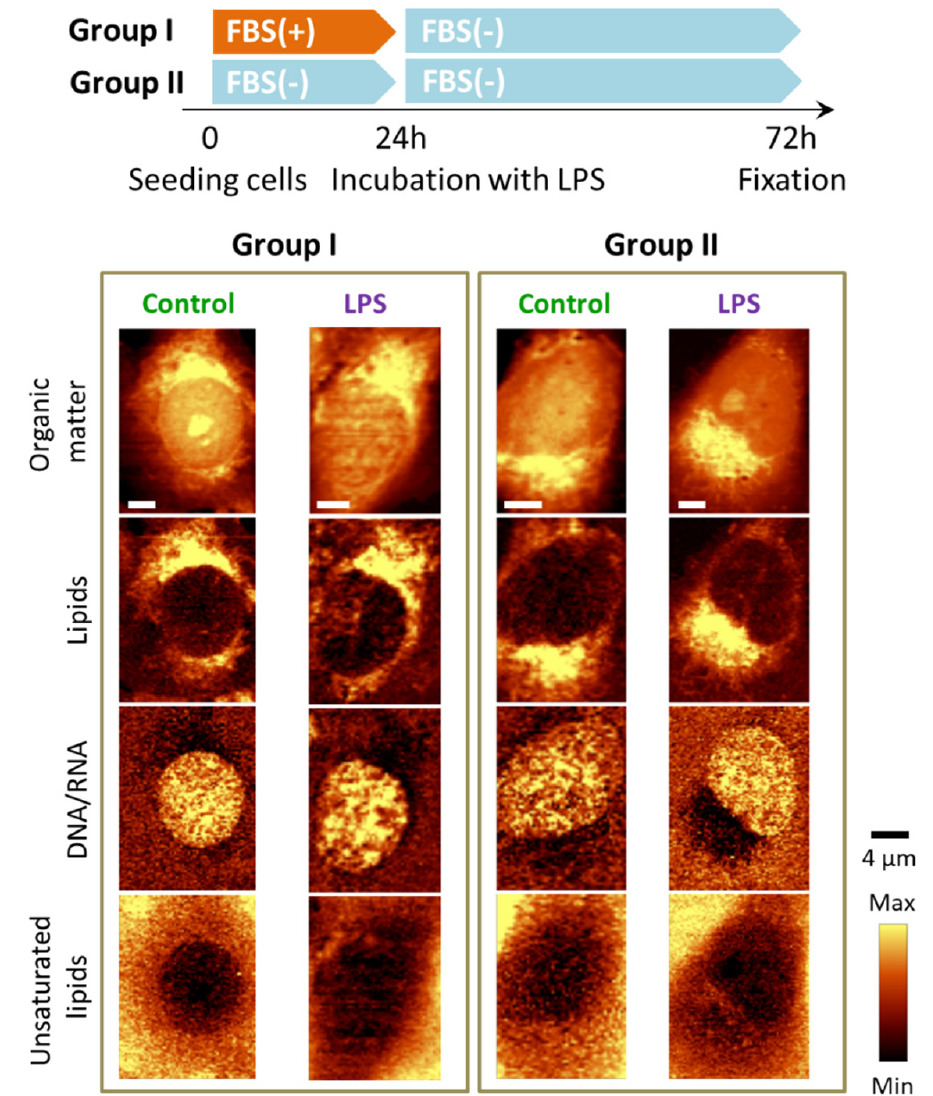
Figure 5. LPS-induced LDs formation in endothelial cells in the absence of FBS. Representative Raman images of the distribution of HMEC-1 incubated without FBS supplementation in various seeding conditions (absence/presence of LPS) obtained by integration in the following spectral regions: 3030–2830 cm − 1 (all organic matter), 2900 − 2830 cm − 1 (lipids), 810 − 760 cm − 1 (DNA & RNA) and 3030–3000 cm − 1 (unsaturated lipids).